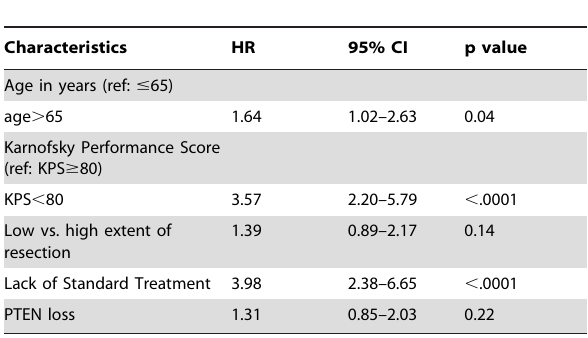
Table 3. Multivariate analysis of Overall Survival: Adjusted hazards ratio (HR) of mortality, 95% Confidence Intervals (CI), and p values.